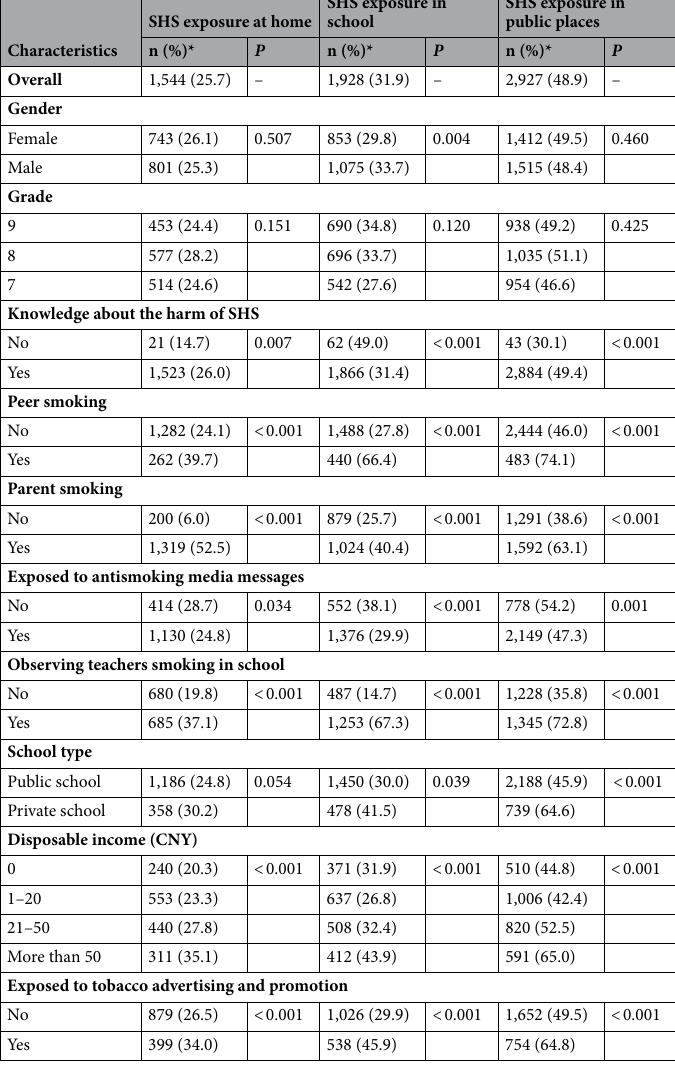
Table 3. Prevalence estimates of secondhand smoke (SHS) exposure among never-smoking adolescents (Weighted). SHS secondhand smoke, CNY Chinese Yuan, 1 United States dollar = 6.7 Chinese yuan. *Unweighted frequencies, weighted